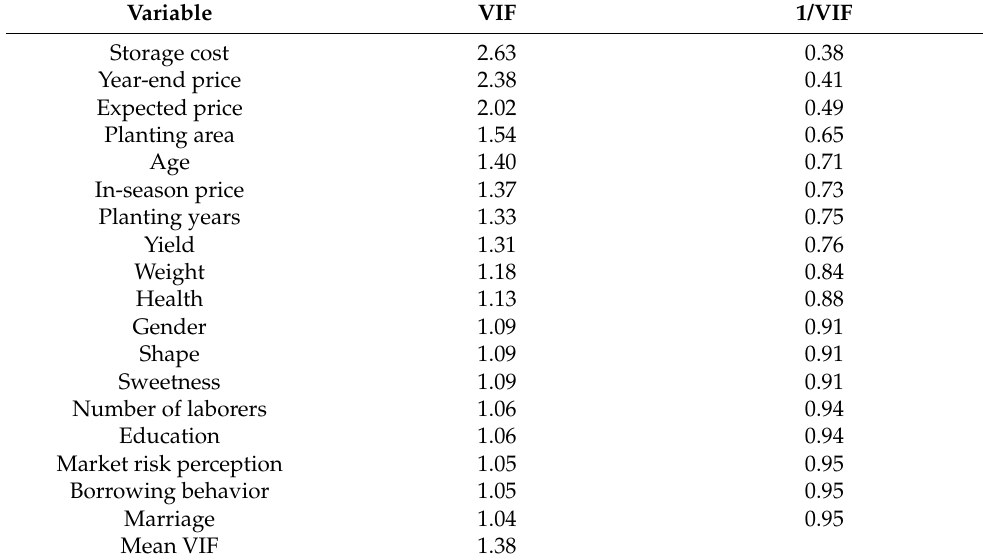
Table 2. Multicollinearity test.